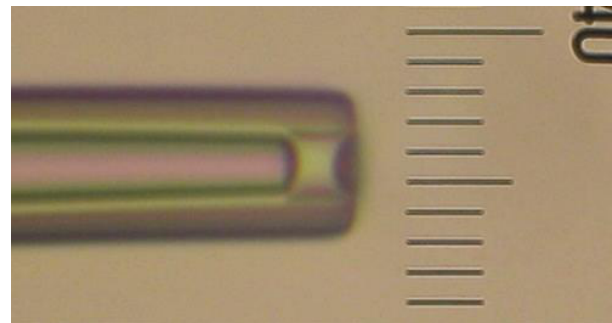
Figure 9. Plastic scintillator end window at a capillary outlet (2.8 µ m / div.). The inner diameter and the thickness are 5 and ~4 m, respectively.